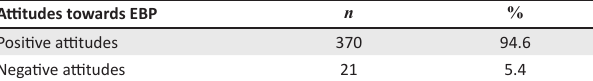
TABLE 3: Summary of attitudes and perceptions regarding evidence-based practice (EBP) ( n = 391). Attitudes towards